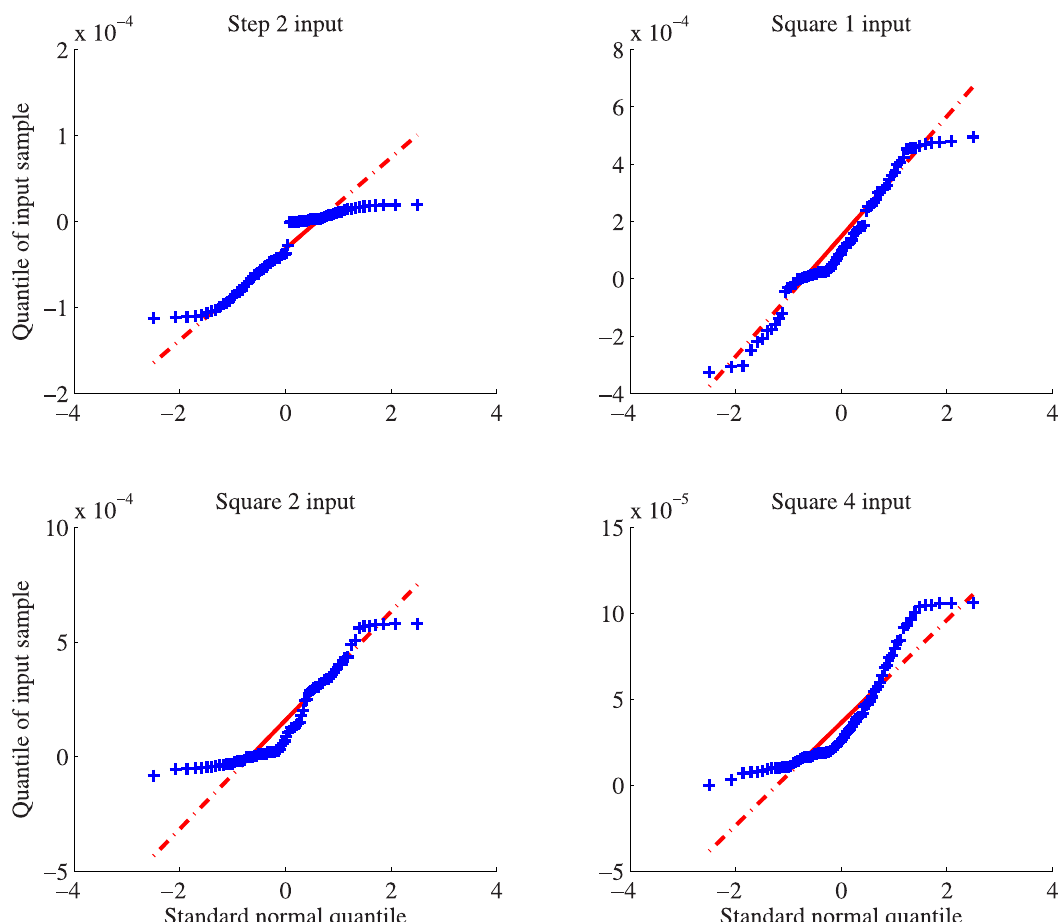
Fig 3. The quantile-quantile(QQ) plots for estimated parameters of unbuffered gene networks using step and periodic inputs. These QQ plots for unbuffered systems show similar patterns observed in error indexes. Squared inputs are likely to reduce the deviation between estimated parameters from the true